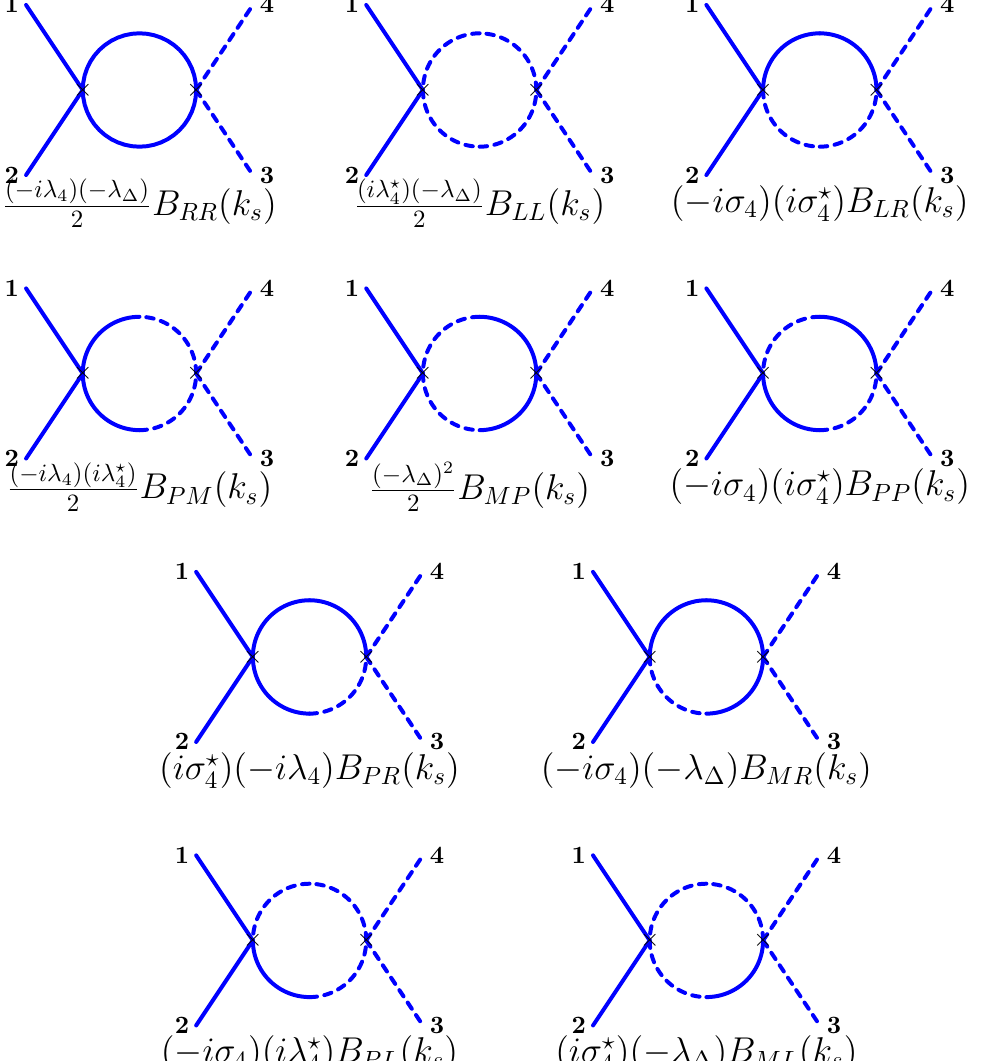
Figure 15. Diagrammatic representation of the Ten 1-Loop Integrals (cid:30) R (cid:30) R k t = k 1 + k 2